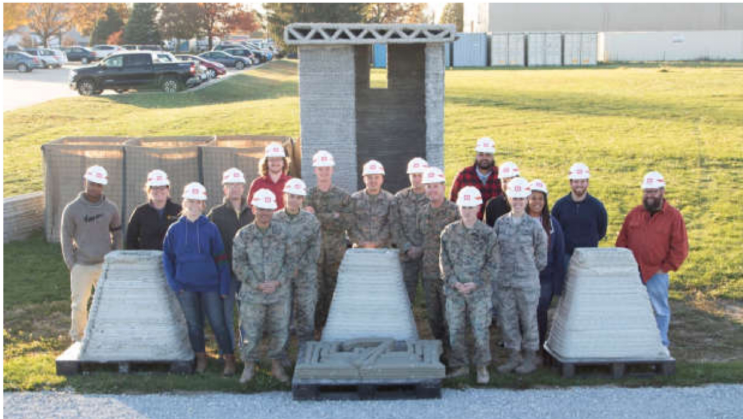
Figure 4. Tri-Service Team with Completed Dragon’s Teeth and 7th ESB